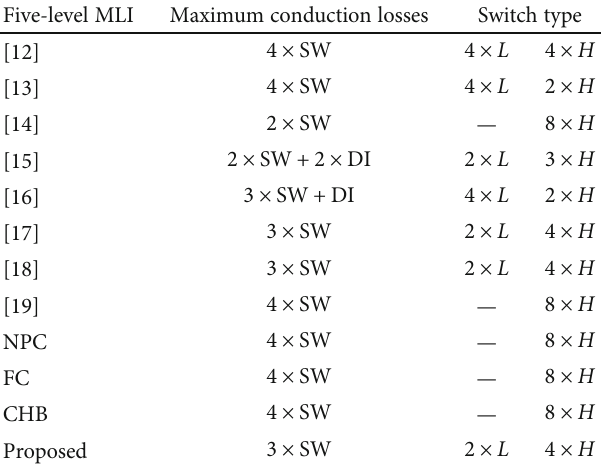
Figure 9: Bidirectional switches: (a) DE_IGBT: diode-embedded IGBT; (b) CC_IGBT: common collector; (c) CE_IGBT: common emitter. Table 4: Comparison between Γ u inverter and some of topologies. Five-level MLI